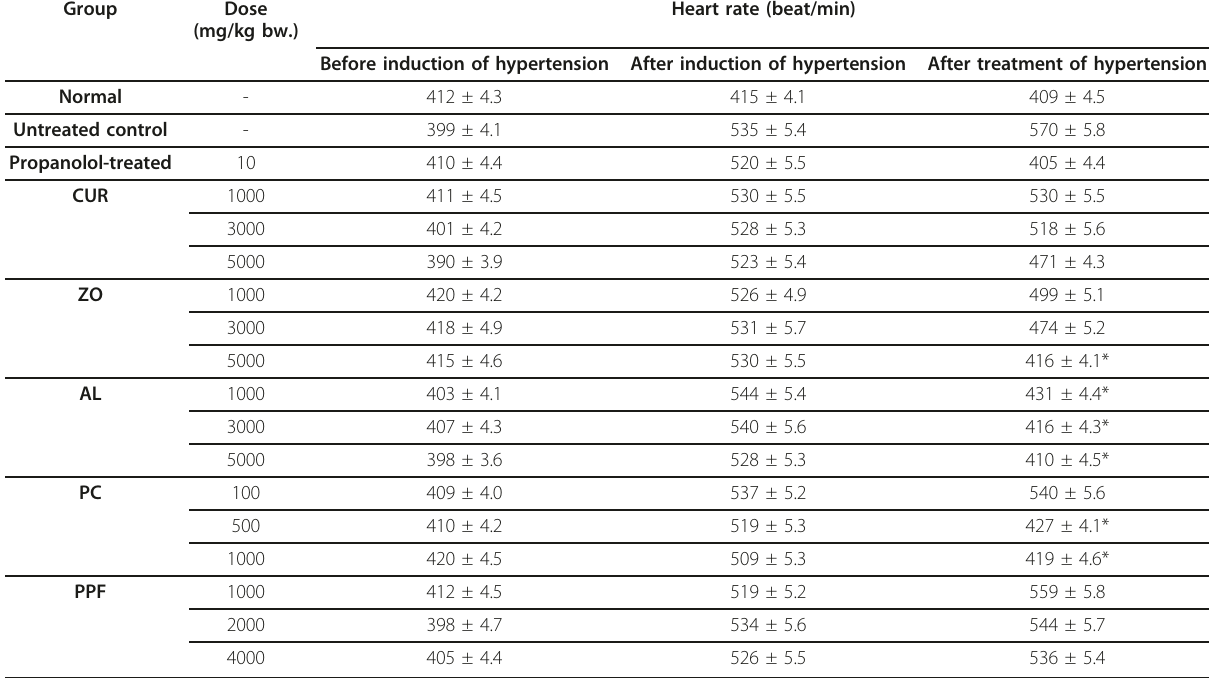
Heart rate (beat/min)